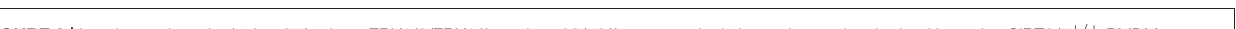
FIGURE 3 | imaging and results (ratio p65/actin, p-ERK1/2/ERK1/2, and p-p38/p38) expressed relative to the results obtained in resting SIRT3/5 + / + BMDMs set at 1. Data are means ± SD from one experiment performed with three mice. Full blots are presented in Supplementary Figure S1 . (C–E) BMDMs were primed with Pam 3 CSK 4 (10ng/ml) for 18h and exposed (colored and white symbols) or not (black symbols) to MSU crystals for the indicated time (C) or 6h (E) . mtROS were quantified using MitoSOX (C) , Idh1, Idh2, Sod1, and Sod2 mRNA levels by RT-PCR (D) and IL-1 β by ELISA (E) . Gene expression levels were normalized to actin levels. A.U, arbitrary unit. Data are mean ± SD of four mice aged 10–12 weeks analyzed in triplicate (C–E) . * P < 0.05; ** P <